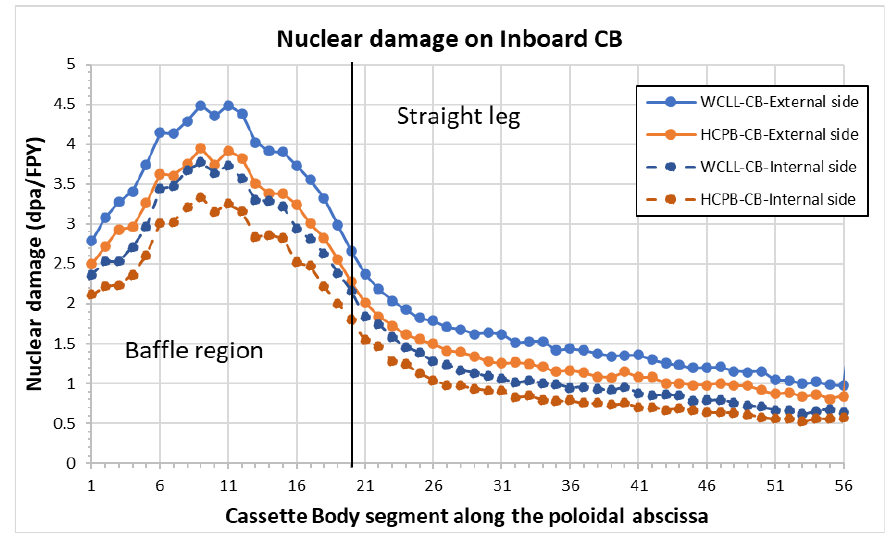
Figure 52. Inner poloidal profiles of the nuclear damage (dpa/FPY) on the first CB layer made of Eurofer, comparing the values on the external and the innermost sides, both for WCLL and HCPB blanket case. blanket case.